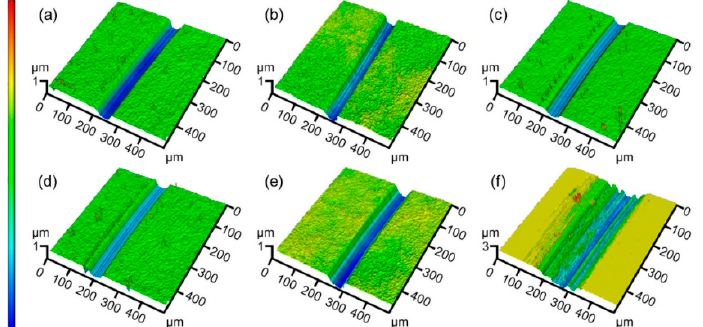
Figure 3. 3D images of the wear tracks formed on the H ‐ DLC films under different sliding velocities. ( a ) 25, ( b ) 100, ( c ) 200, ( d ) 400, ( e ) 600, and ( f ) 1000 mm/s. Note the depth ‐ scale for condition of 1000 mm/s in ( f ) is three times larger than those for other conditions.